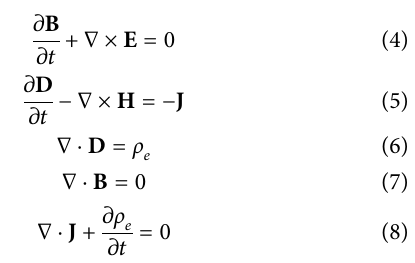
Helium plasma is considered as a single continuous fl uid. (cid:129) The plasma is optically thin and modelled using the Local Thermodynamic Equilibrium (LTE) model.